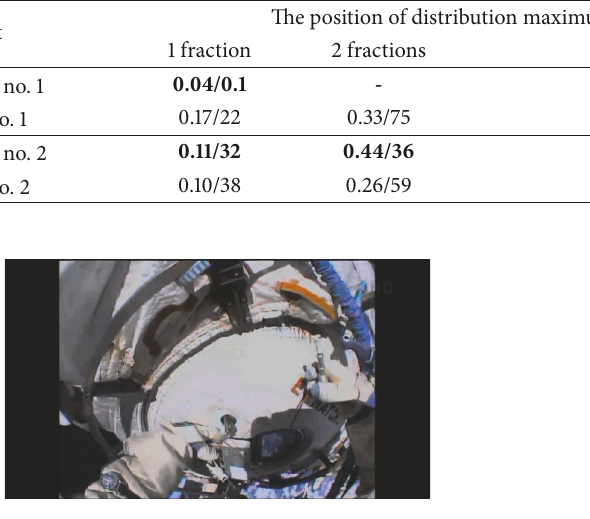
Figure 1: The process of sampling with sampler “TEST.” Astronaut holds the body of sampler “TEST” in his left hand and the tampon holder screwed out in the open space in the right hand. Figure 2: The process of the sampler “TEST” opening in the lab in a laminar flow hood with protection degree II. Room where the sample was processed had been pretreated with UV for 24 hours.